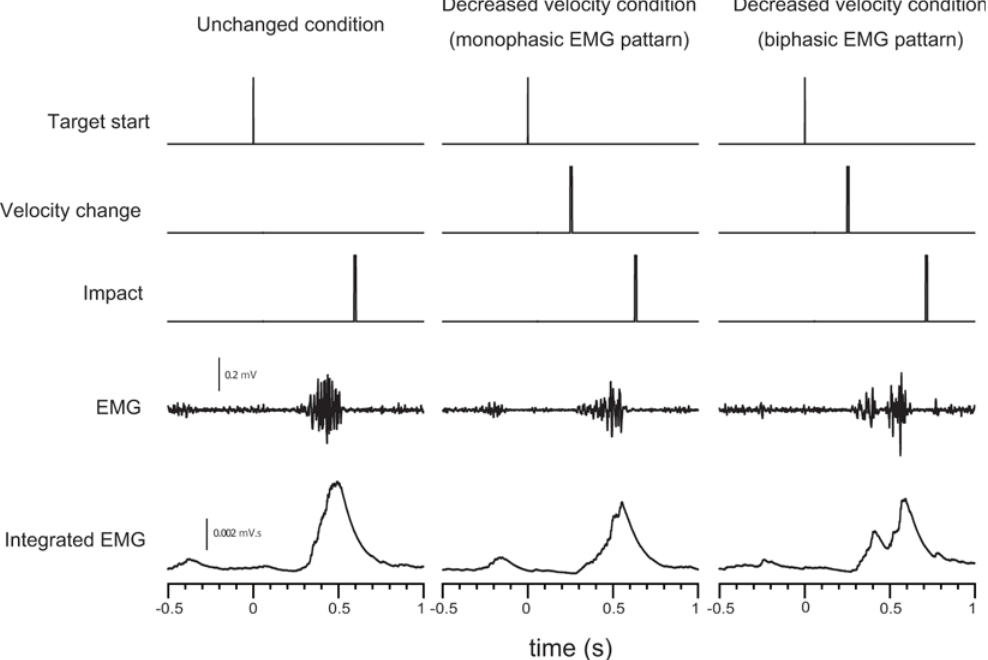
Fig 1. Example of time course of EMG signals in vastus lateralis muscle of front leg. Monophasic and biphasic EMG activation of vastus lateralis muscle of front leg of one participant in response to unchanged and decreased velocity conditions, respectively. Target start time was 0 s.